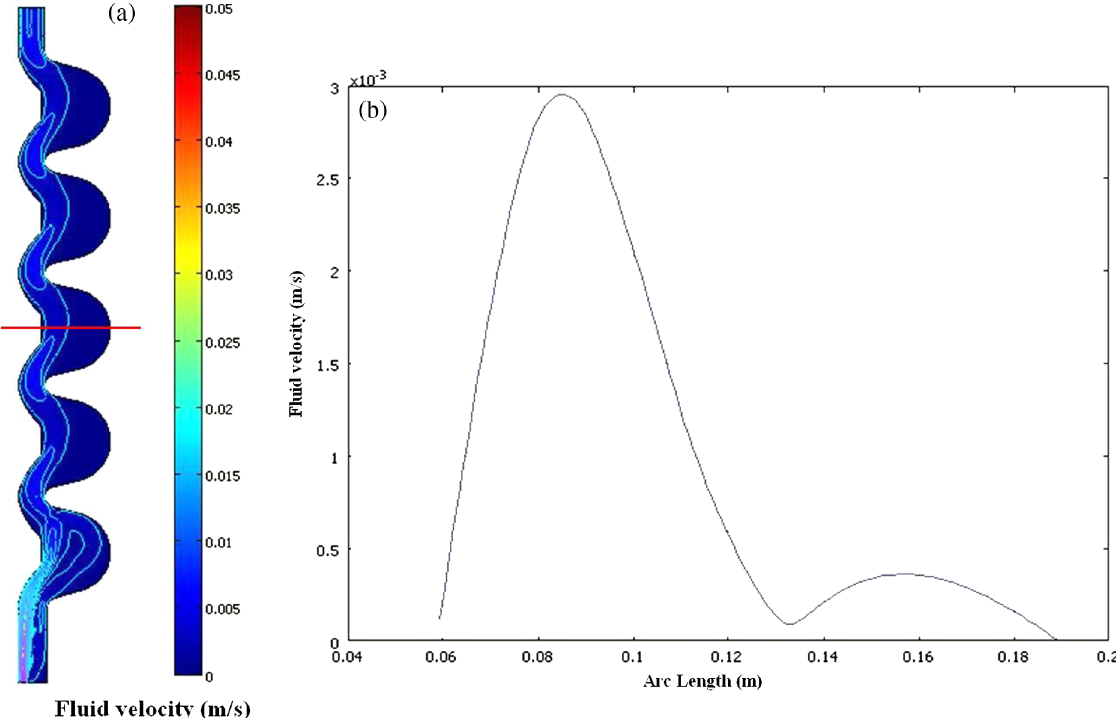
FIG. 10. (a) Fluid distribution in the five-cell SPL cavity and (b) fluid velocity profile along the line. The shaped cathode makes it possible to increase fluid velocity in the